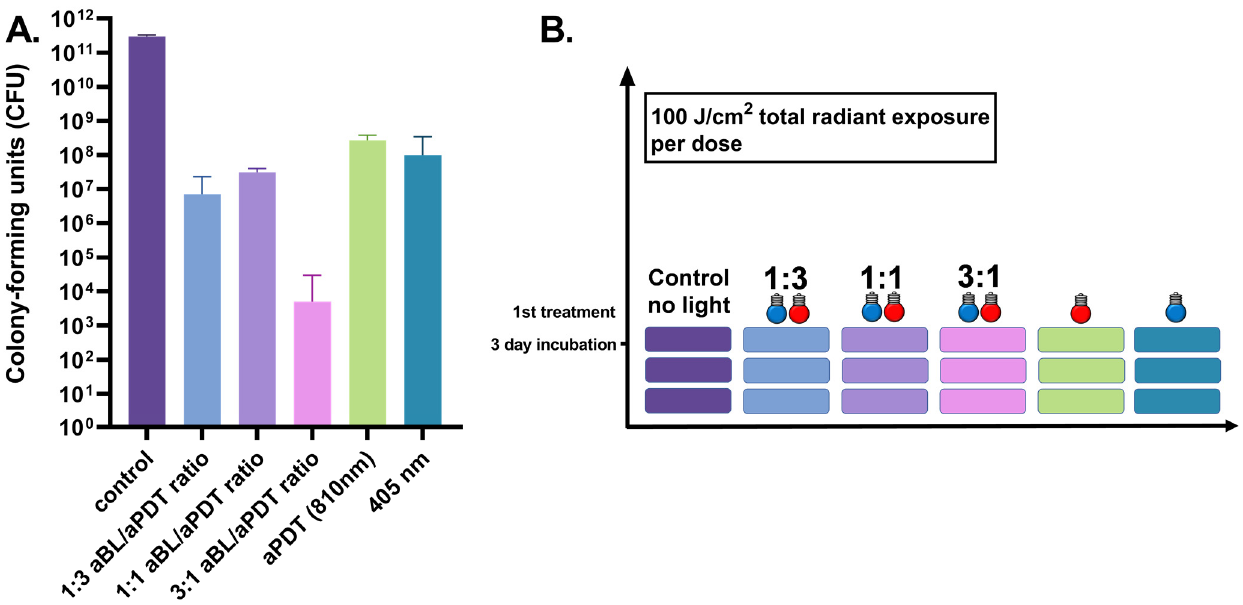
Figure 2. ( A ). Effects of different irradiance ratios of aBL and aPDT in the dual-light aPDT system in three-day S. aureus biofilm. Three-day S. aureus biofilm, single dose, aBL vs. dual-light 1:3 aBL/aPDT ratio, p = 0.17; aBL vs. dual-light 1:1 aBL/aPDT ratio, p = 1.0; aBL vs. dual-light 3:1 aBL/aPDT ratio, p = 0.0001; aPDT vs. dual-light 1:3 aBL/aPDT ratio, p = 0.0022; aPDT vs. dual-light 1:1 aBL/aPDT ratio, p = 0.0022; aPDT vs. dual-light 3:1 aBL/aPDT ratio, p = 0.0001; aBL vs. aPDT, p = 0.13; dual-light aPDT: 1:3 aBL/aPDT ratio vs. 1:1 aBL/aPDT ratio, p = 0.011; 1:3 aBL/aPDT ratio vs. 3:1 aBL/aPDT ratio, p = 0.0001; 1:1 aBL/aPDT ratio vs. 3:1 aBL/aPDT ratio; p = 0.0001. The y -axis displays the median of CFUs. Six assays were performed for each experiment, and the control biofilm was performed in three assays. The 95% confidence interval (CI) is presented by using t-bars. ( B ). A schematic representation of the experiment.